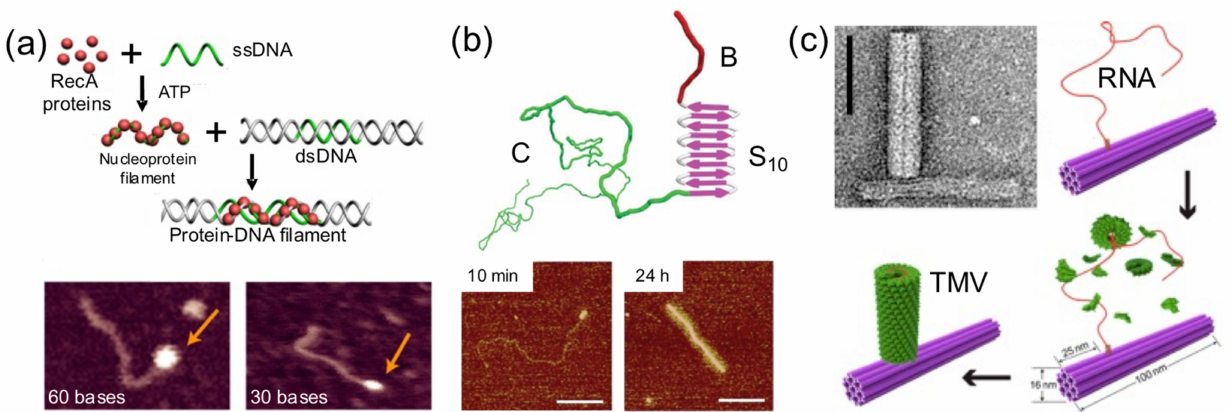
Figure 7. Protein self-assembly on DNA templates. ( a ) RecA protein self-assembles on a ssDNA oligonucleotide before forming complexes with dsDNA (top). AFM images of the hybrid nanostructures (bottom). Adapted from [44], with permission from American Chemical Society, 2014. ( b ) A tri-block C 4 -S 10 -B K12 protein polymer self-assembles onto dsDNA to form hybrid nanorods (top). AFM images (bottom). Scale bars: 100 nm. Adapted from [30], with permission from Springer Nature, 2014. ( c ) TMV capsid protein self-assembles on a ssRNA carrying the TMV origin of assembly attached to a DNA origami forming L-shaped hybrid nanostructures. TEM image (top left). Scale bar: 50 nm. Adapted from [34], with permission from American Chemical Society,